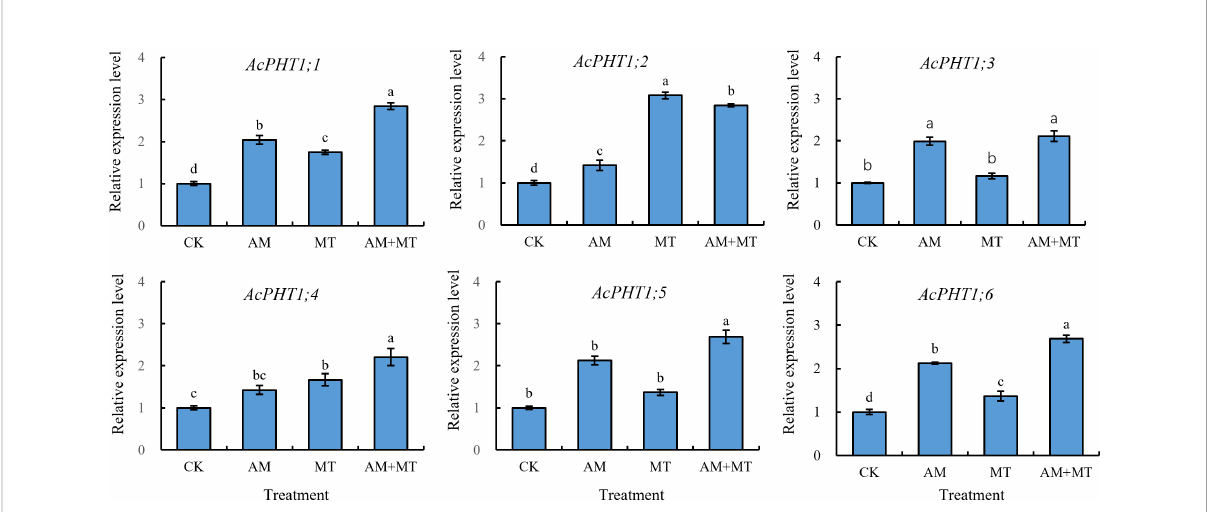
FIGURE 9 The relative expression pro fi les of phosphorus transport genes in the kiwifruit seedling under drought stress. Data are presented as meant ± SD ( n = 6), different letters indicate signi fi cant differences between treatments at p < 0.05 by Tukey ’ s Post Hoc test. Treatments included CK (the control), AM (inoculated with arbuscular mycorrhiza), MT (irrigated with 100 m M melatonin), and AM+MT (treated with melatonin and arbuscular